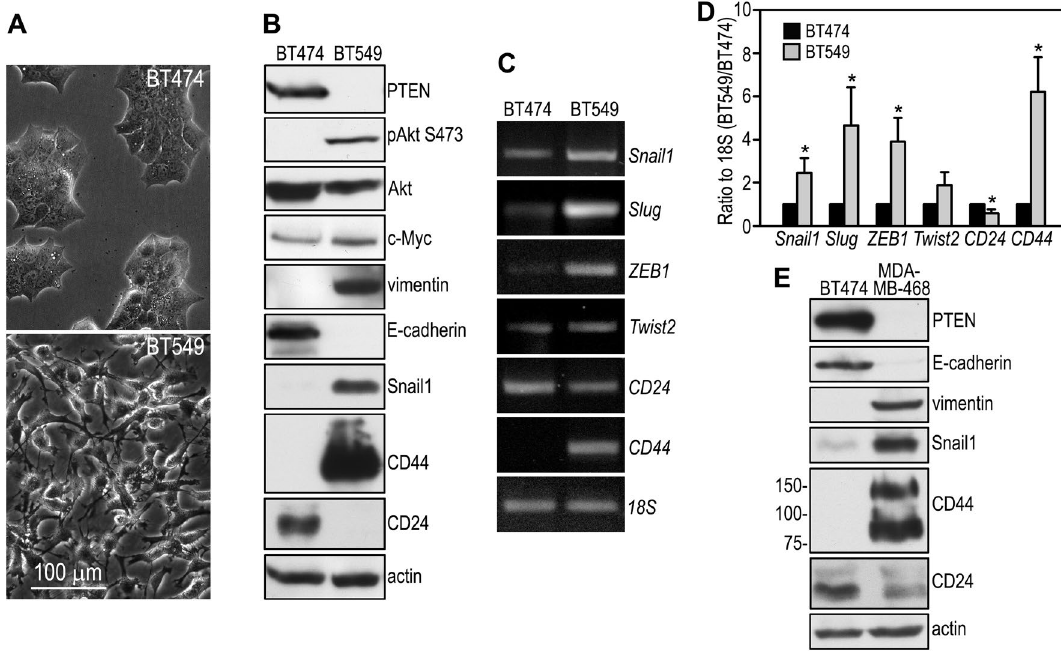
Figure 1. PTEN expression correlates with the EMT and stem cell signature in breast cancer cells. ( A ) Phase contrast micrographs show that BT474 breast cancer cells display an epithelial morphology while BT549 cells assume a mesenchymal, fibroblast-like shape. ( B ) Confluent BT474 and BT549 cells were analyzed by immunoblotting. Actin served as a loading control. ( C ) RT-PCR analysis of BT474 and BT549 cells for the expression of the EMT-inducing transcription factors, CD44, and CD24. 18S was used as a loading control. ( D ) Ethidium bromide-stained PCR products were quantified by densitometry and plotted as a ratio to 18S. N = 3, * P < 0.05 versus BT474. ( E ) BT474 and MDA-MB-468 cells were cultured to confluence and subjected to immunoblot analysis. Actin was used as a loading